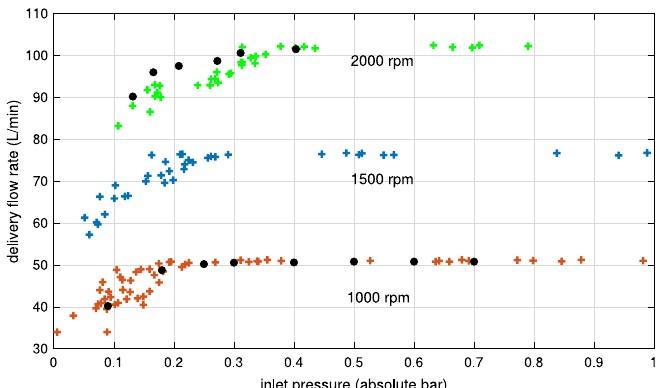
Figure 14. Delivered flow rate vs. internal inlet pressure: comparison between experimental (colored crosses) and simulated (black dots) steady-state operating points. Thrust plates type B.